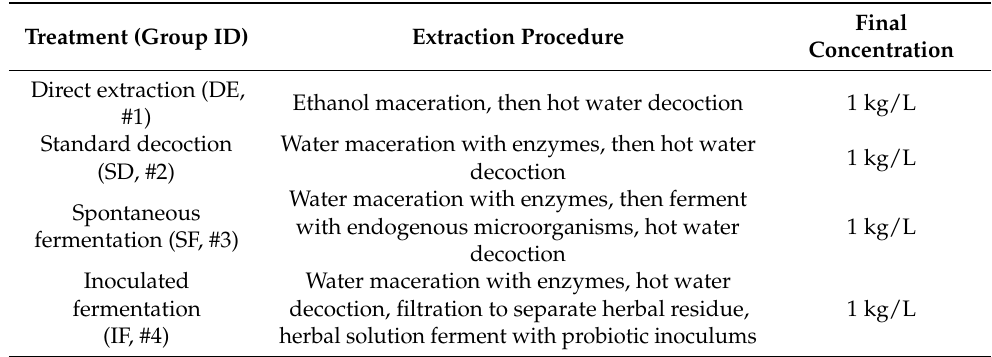
Table 1. Experimental setup and corresponded